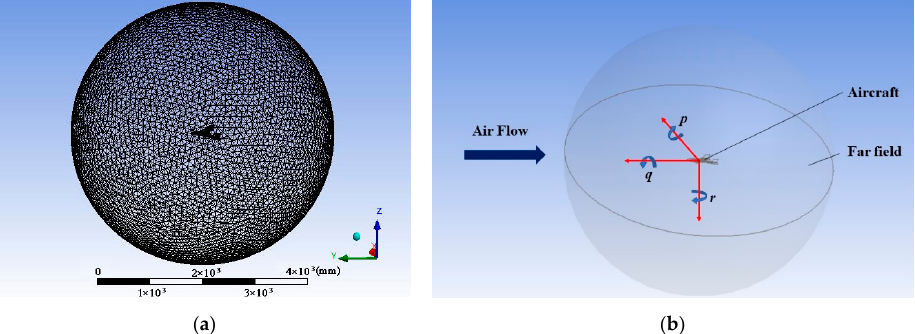
Figure 6. Grids for far-field and boundary conditions. ( a ) Meshes of the fluid domain; ( b ) bound-